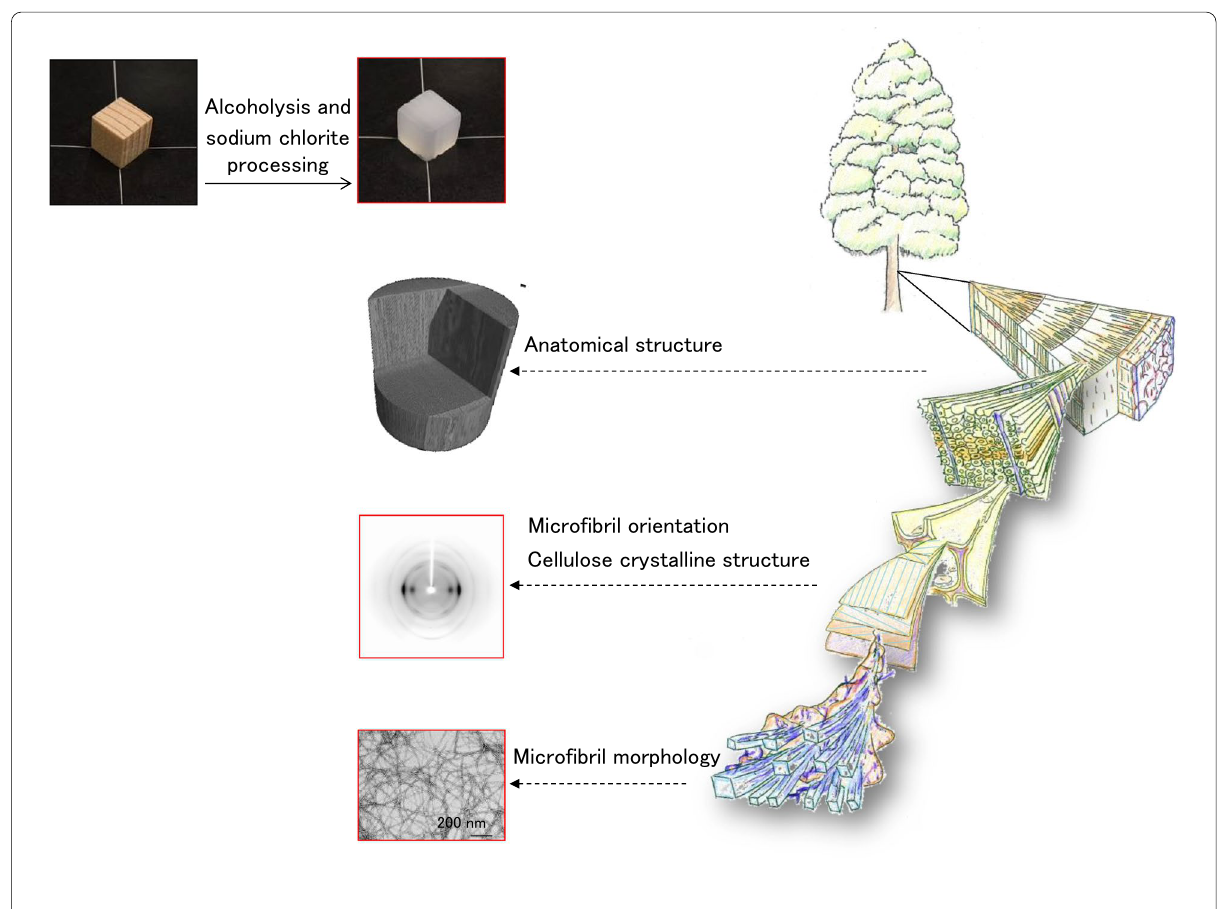
Fig. 1 Development of colorless wood by two-step delignification and structural analysis of the hierarchical architecture (reproduced from